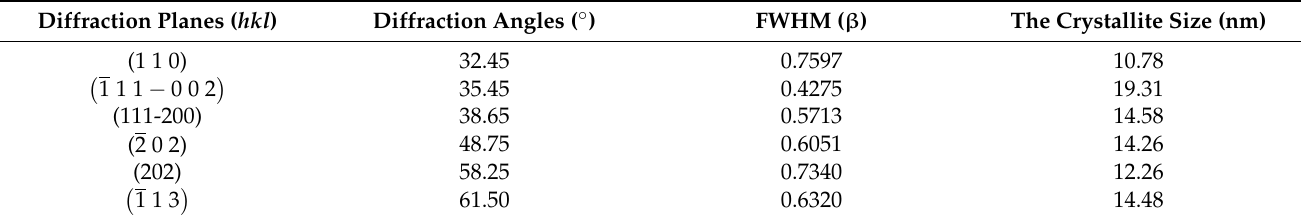
Table 1. Diffraction parameters for leaf-shaped CuO nanosheets.